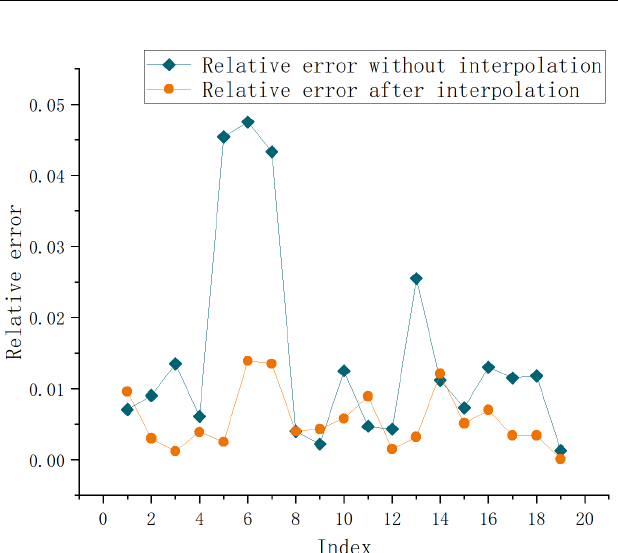
Figure 22. The effect of interpolation processing.